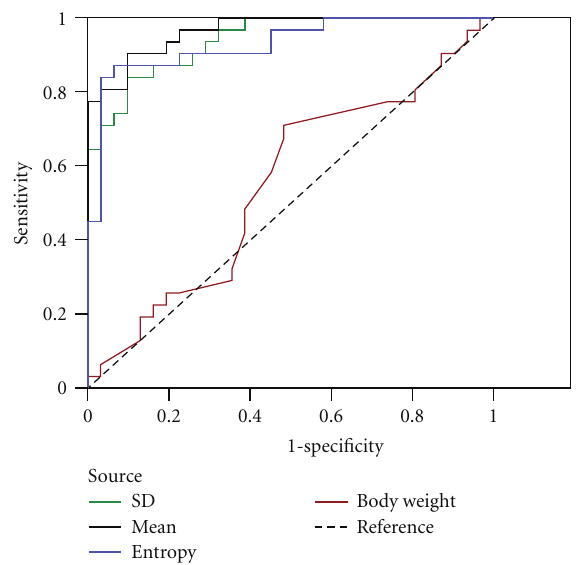
Figure 3: The ROC of extracted features of image (SD, mean, entropy of pixel intensity in the ROI) and body weight associated with normal and abnormal